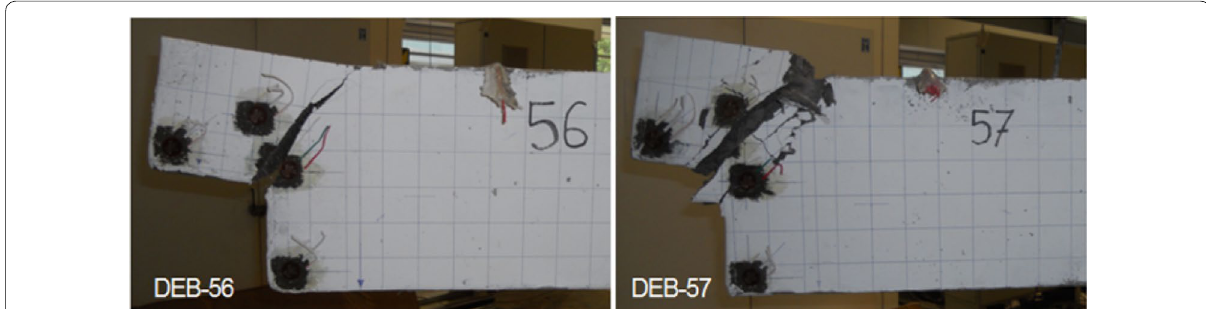
Fig. 13 The beam condition after testing (For DEB-56 and